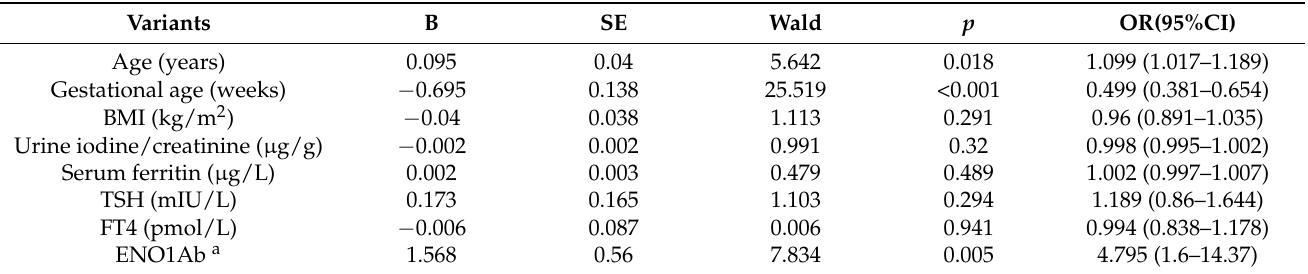
Table 2. Logistic regression of potential risk factors of miscarriage in euthyroid pregnant women without AIT.